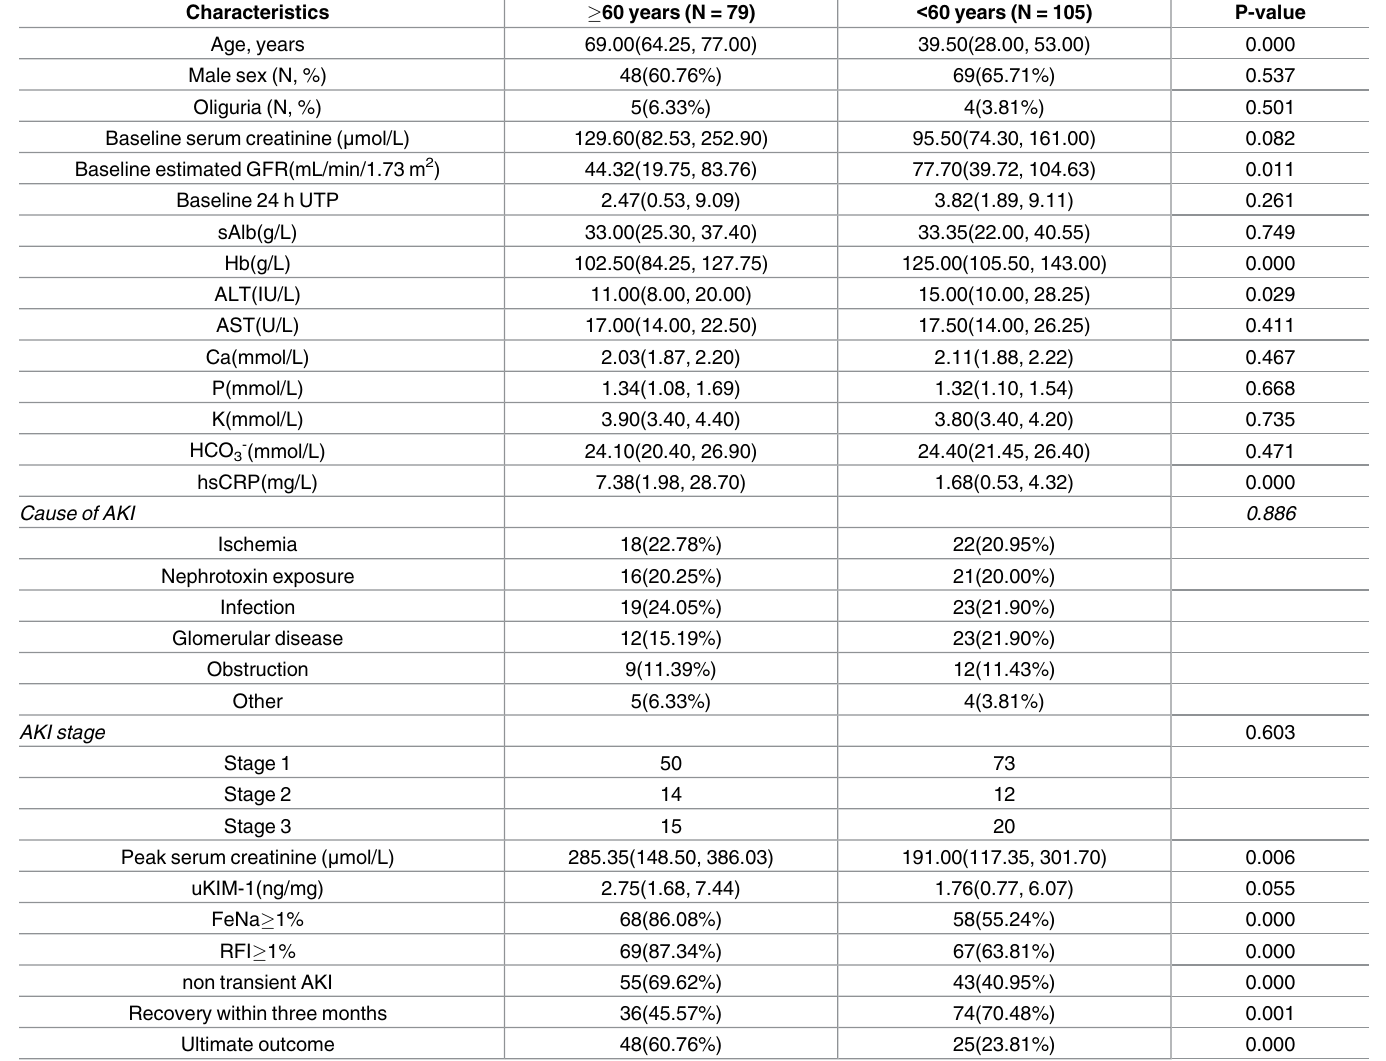
Table 2. Comparison between different age groups.